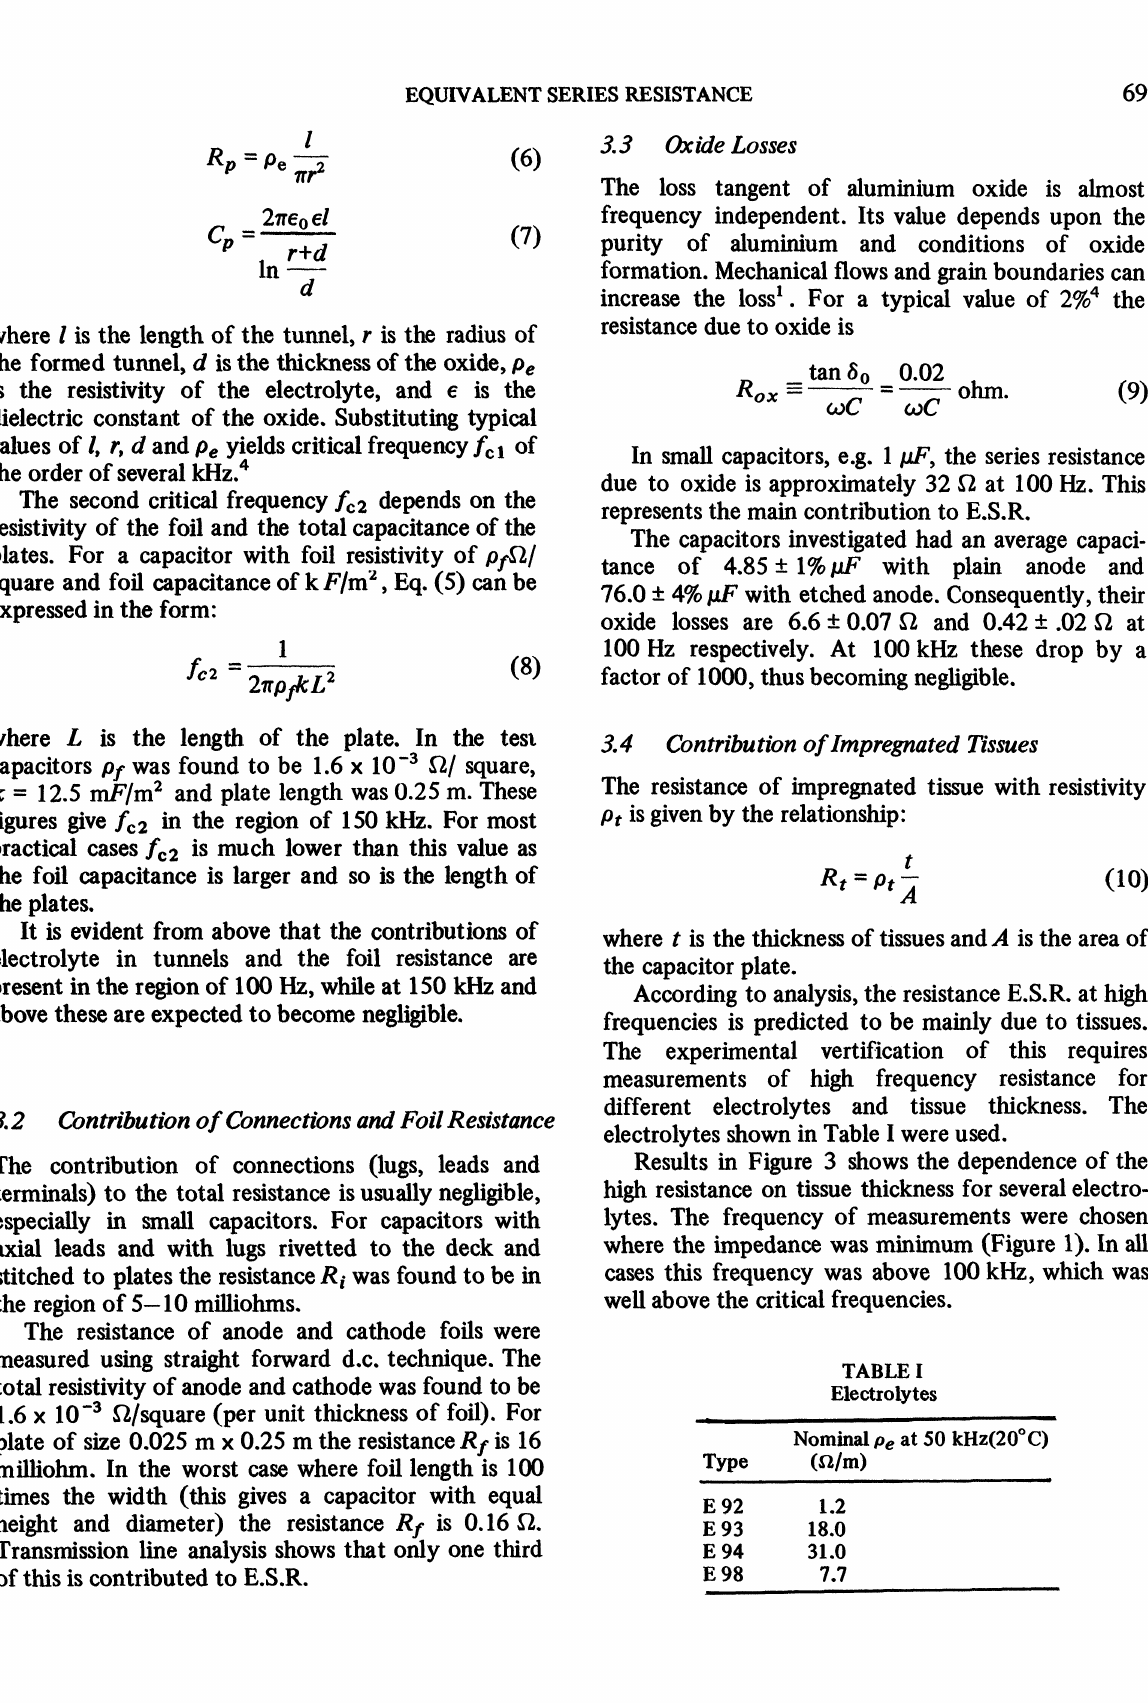
Nominal Pe at 50 kHz(20 C)